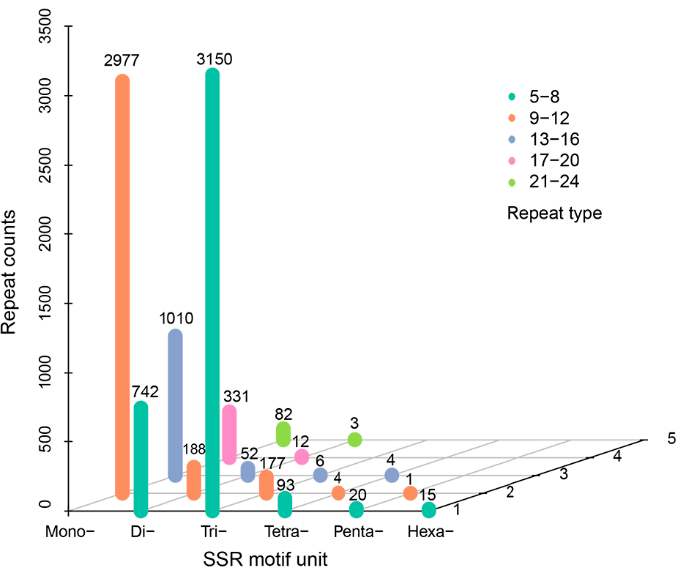
Figure 7. The distribution of the detected simple sequence repeats (SSRs) in the Heterosigma akashiwo transcriptome. Mono: mononucleotide; Di: dinucleotide; Tri: trinucleotide; Tetra: tetranucleotide; Penta: pentanucleotide; and Hexa: hexanucleotide. The detail information of these genes is listed in Table S6.